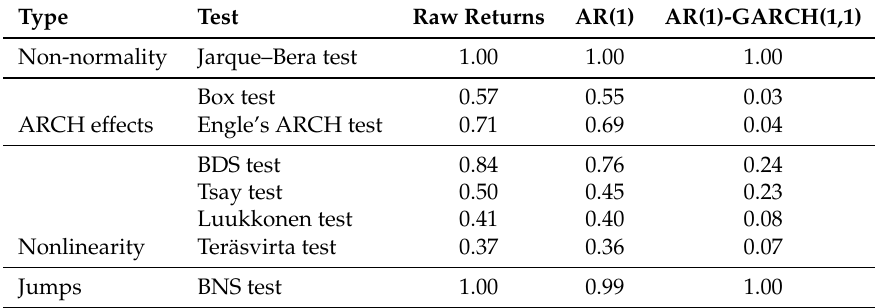
Table 1. Evaluation of minute-binned stock return data of the DAX 30 constituents over the 249 trading days in 2014. Subject to testing are raw returns, the residuals after AR(1)-filtration and the residuals after AR(1)-GARCH(1,1)-filtration. Depicted is the share of tests with a p -value less than 0.05.